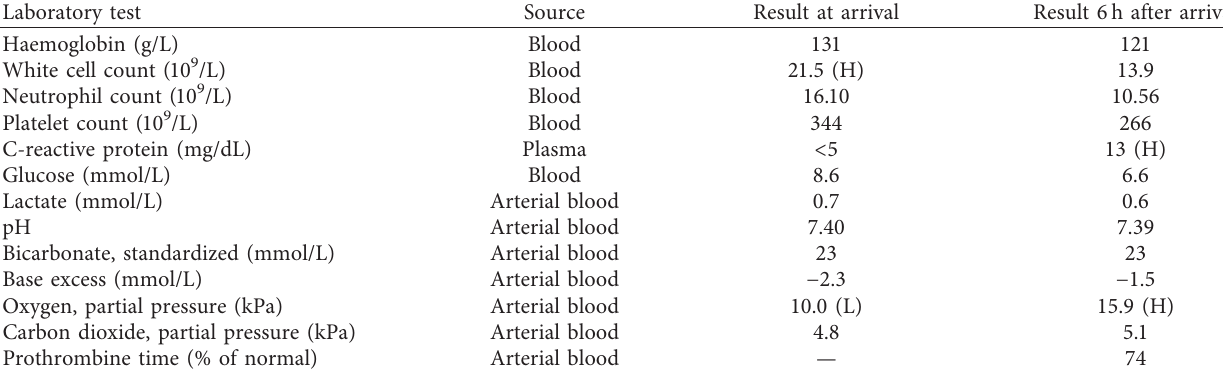
Table 1: Laboratory values at arrival at night and the next morning.